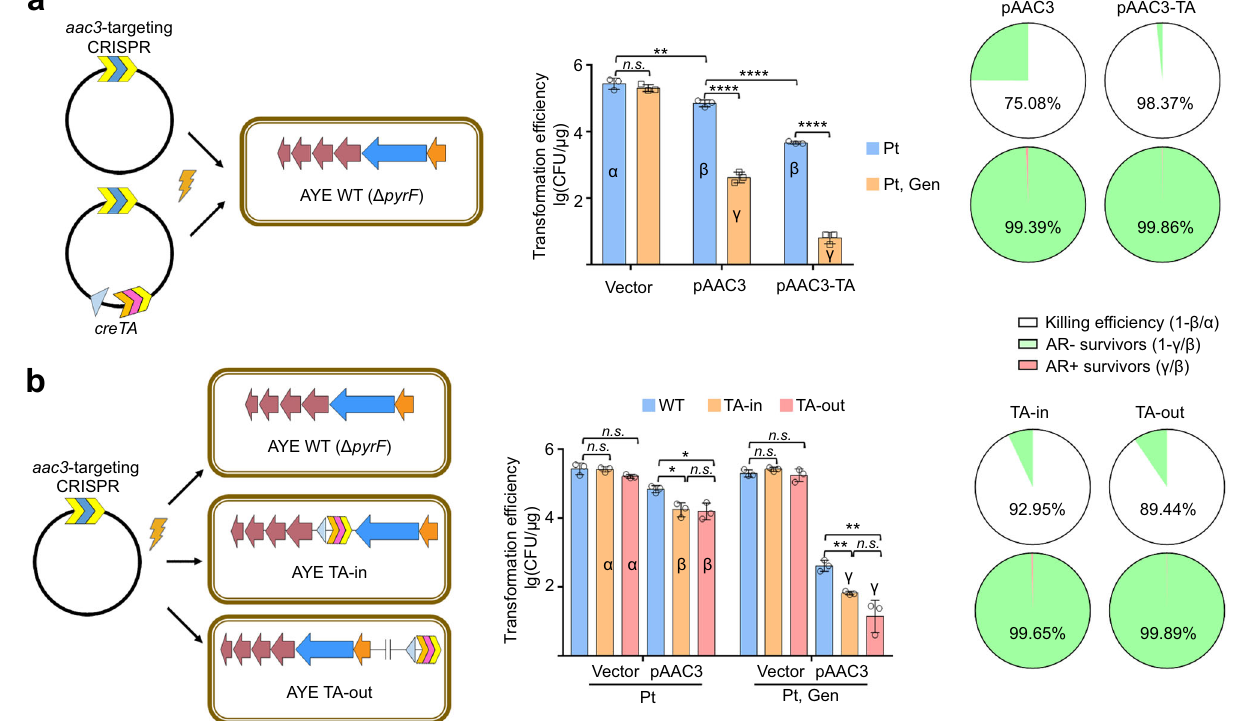
Fig.5|An aac3 -targetingCRISPRkilled A.baumannii AYEcellsmoreef fi ciently in the presence of CreTA. a Kill AYE cells using an aac3 -targting CRISPR alone (pAAC3) or together with a Ψ R-replaced WCHA45 creTA module(pAAC3-TA).Data arepresentedasmeanvalue±s.d.( n =3biologicalreplicates).Two-tailedStudent ’ s t test [ n.s ., not signi fi cant ( P >0.05); ** P <0.01; **** P <0.0001. P